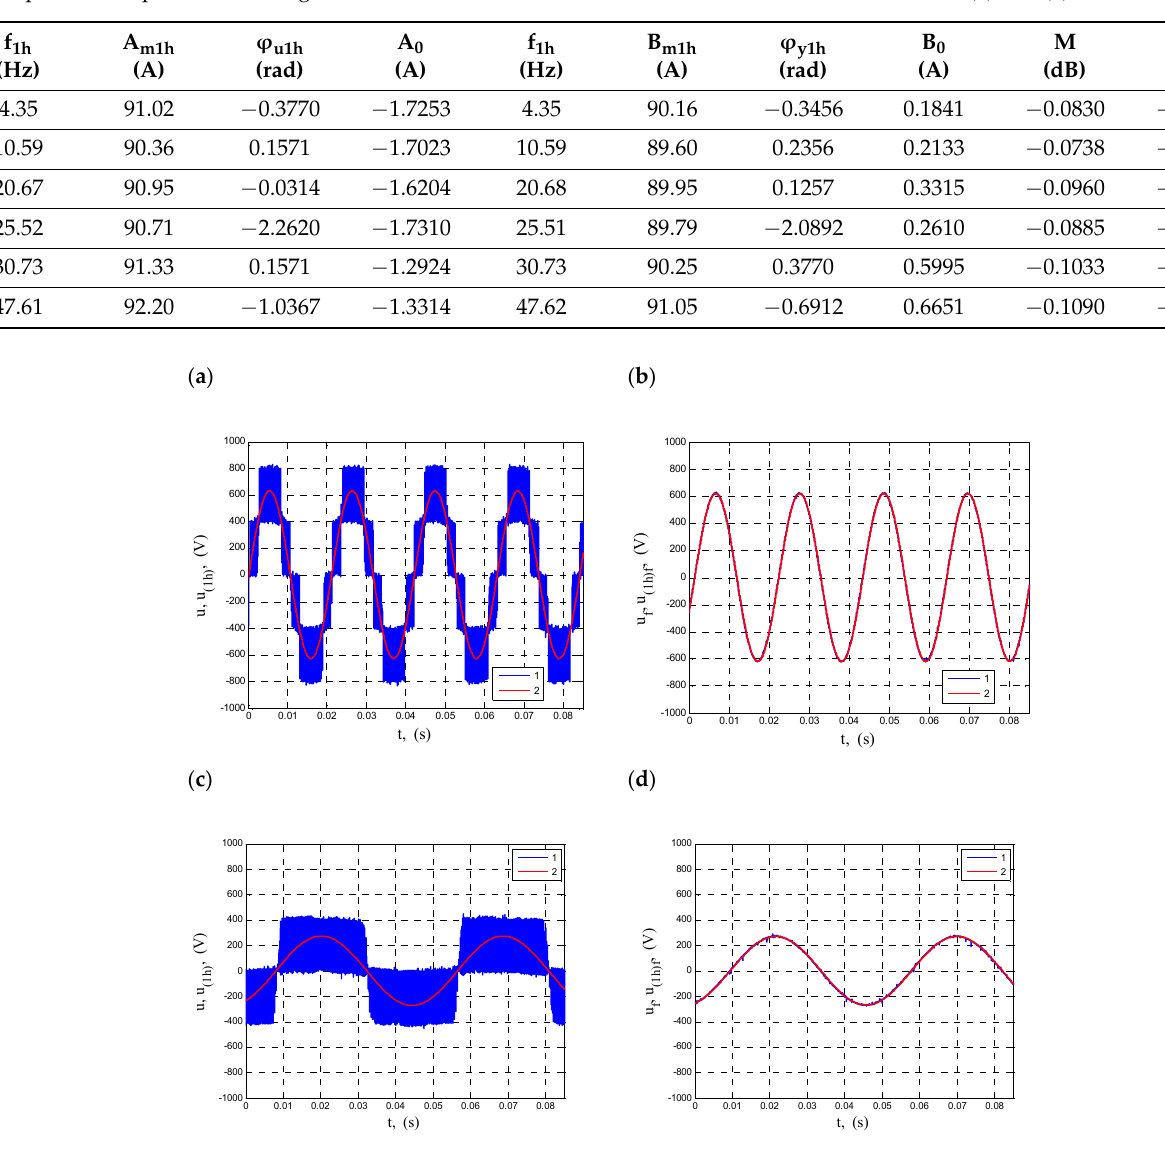
Figure 7. Estimated waveforms of the fundamental harmonic of the voltage supplying the motor against the background of the measuring signal at the input ( a , c ) and the output of the analog filter ( b , d ) with the frequencies ( a , b ) 47.59 Hz and ( c , d ) 20.64 Hz; 1—measurement data, 2—identified voltage fundamental harmonic.